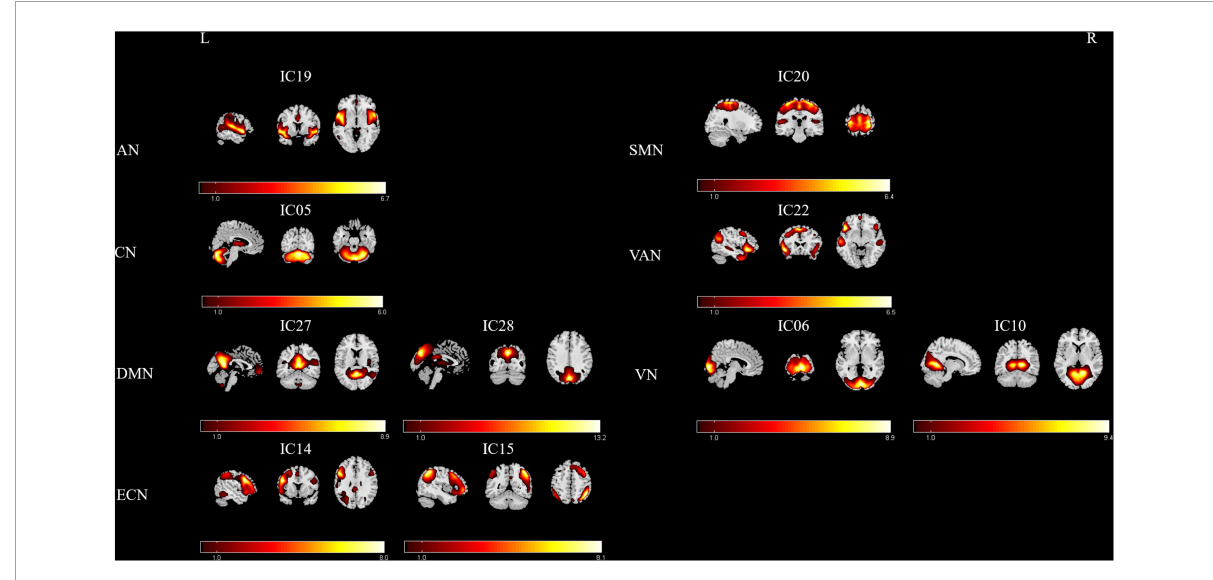
FIGURE1 Relevant RSNs extracted from the group-level ICA. The spatial maps of 10 ICs were selected as the RSNs for further analysis. AN, auditory network; CN, cerebellum network; DMN, default mode network; ECN, executive control network; SMN, sensorimotor network; VAN, ventral attention network; VN, visual network. R, Right; L,